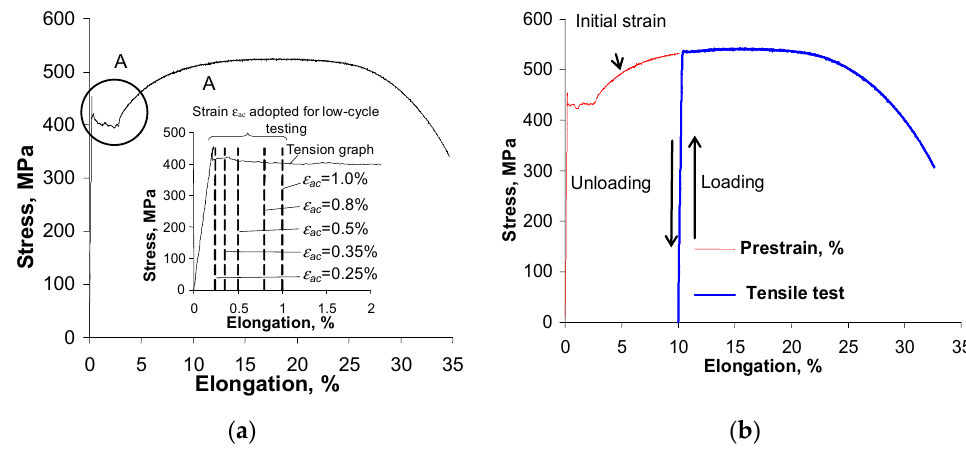
Figure 3. Tensile graphs: ( a ) classic tests, ( b ) tests with unloading. Table 2. Static test results.